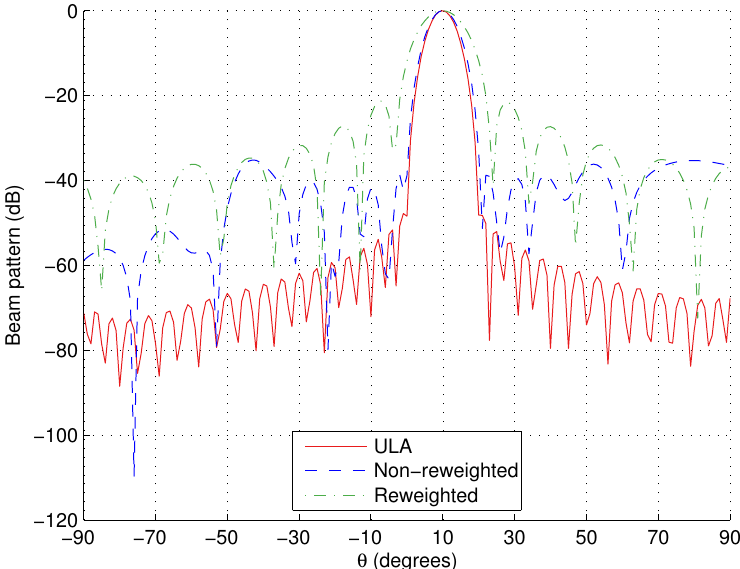
Figure 3. Responses for off-broadside design example, θ ML = 10 ◦